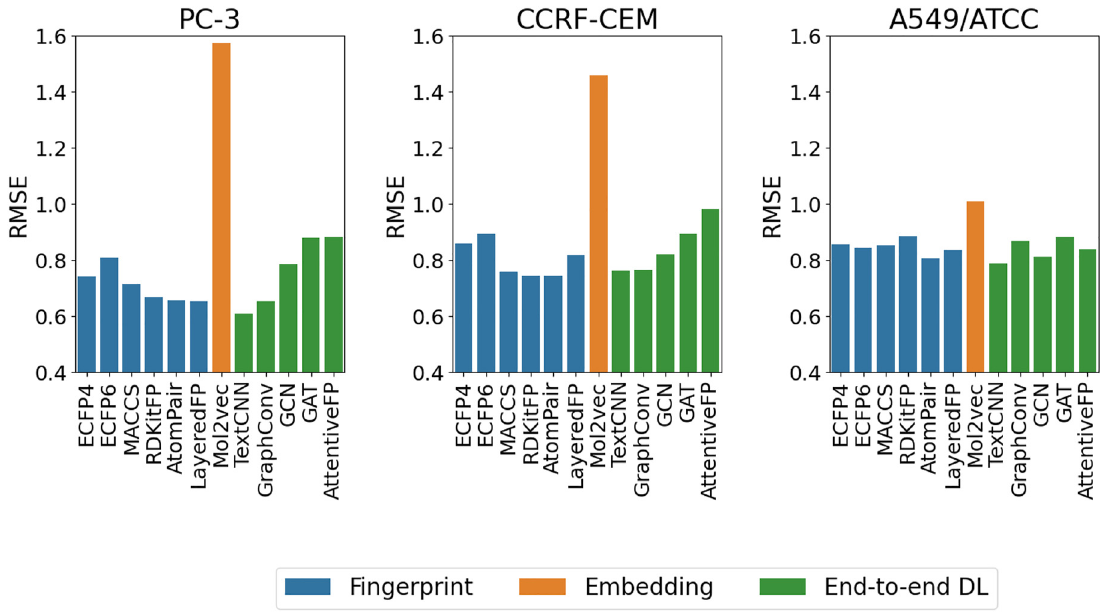
Figure 5: Performance (RMSE) of different deep learning models on the PC-3, CCRF-CEM and NCI-60 A549 regression tasks. Lower scores mean better